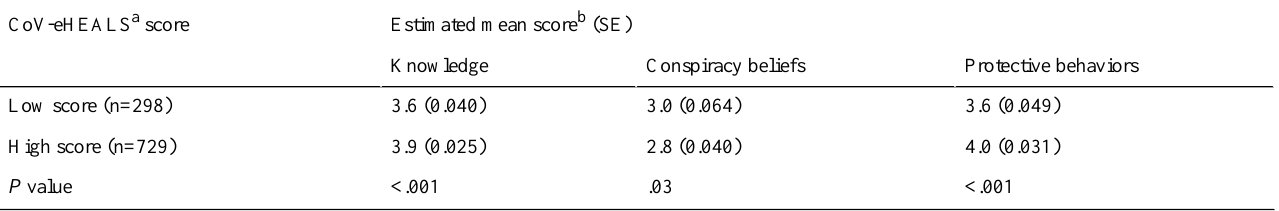
Table 4. COVID-19 knowledge, conspiracy beliefs, and protective behaviors for respondents with low and high coronavirus-related eHealth literacy.